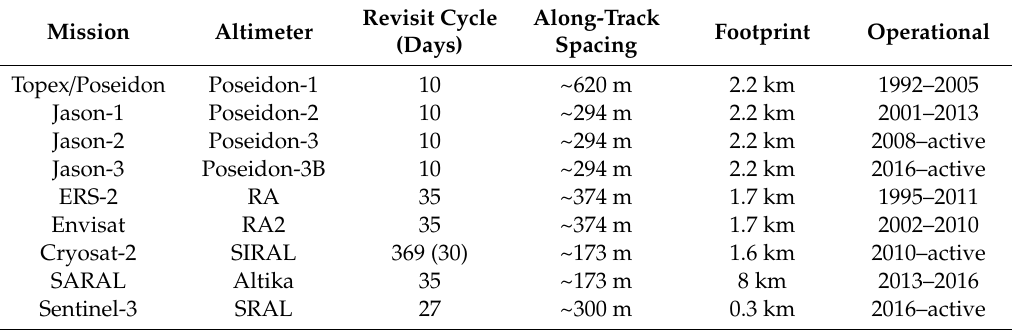
Table 1. List of all altimeter missions used in this study, together with their main characteristics. Mission